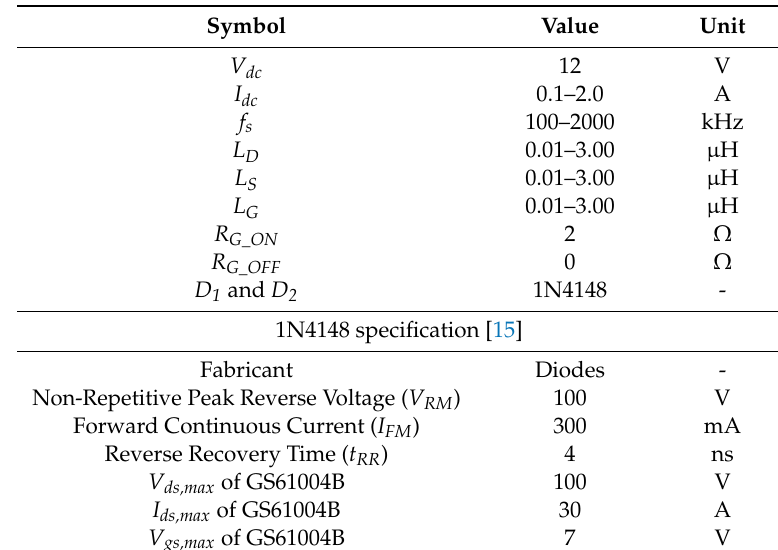
Figure 1. The proposed measurement system to assess electrical characteristics of enhancement-mode gallium-nitride high-electron-mobility transistors (E-mode GaN HEMT). Table 2. Experimental parameters of Figure 1.